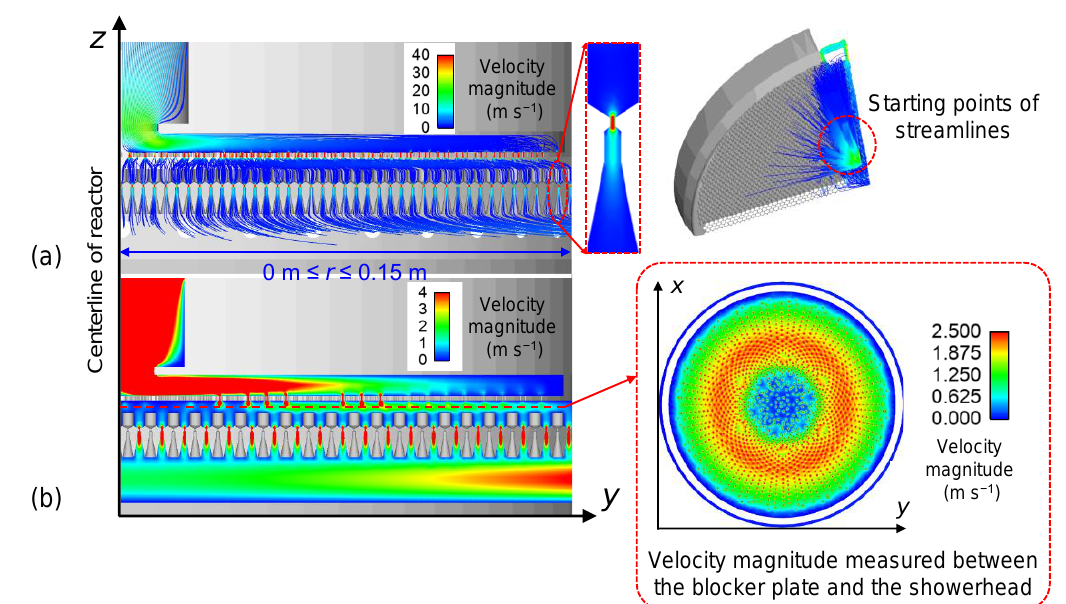
Figure 2. The 3D gas flow simulation results for Case 1: ( a ) streamlines and ( b ) gas velocity magnitude contour plot.